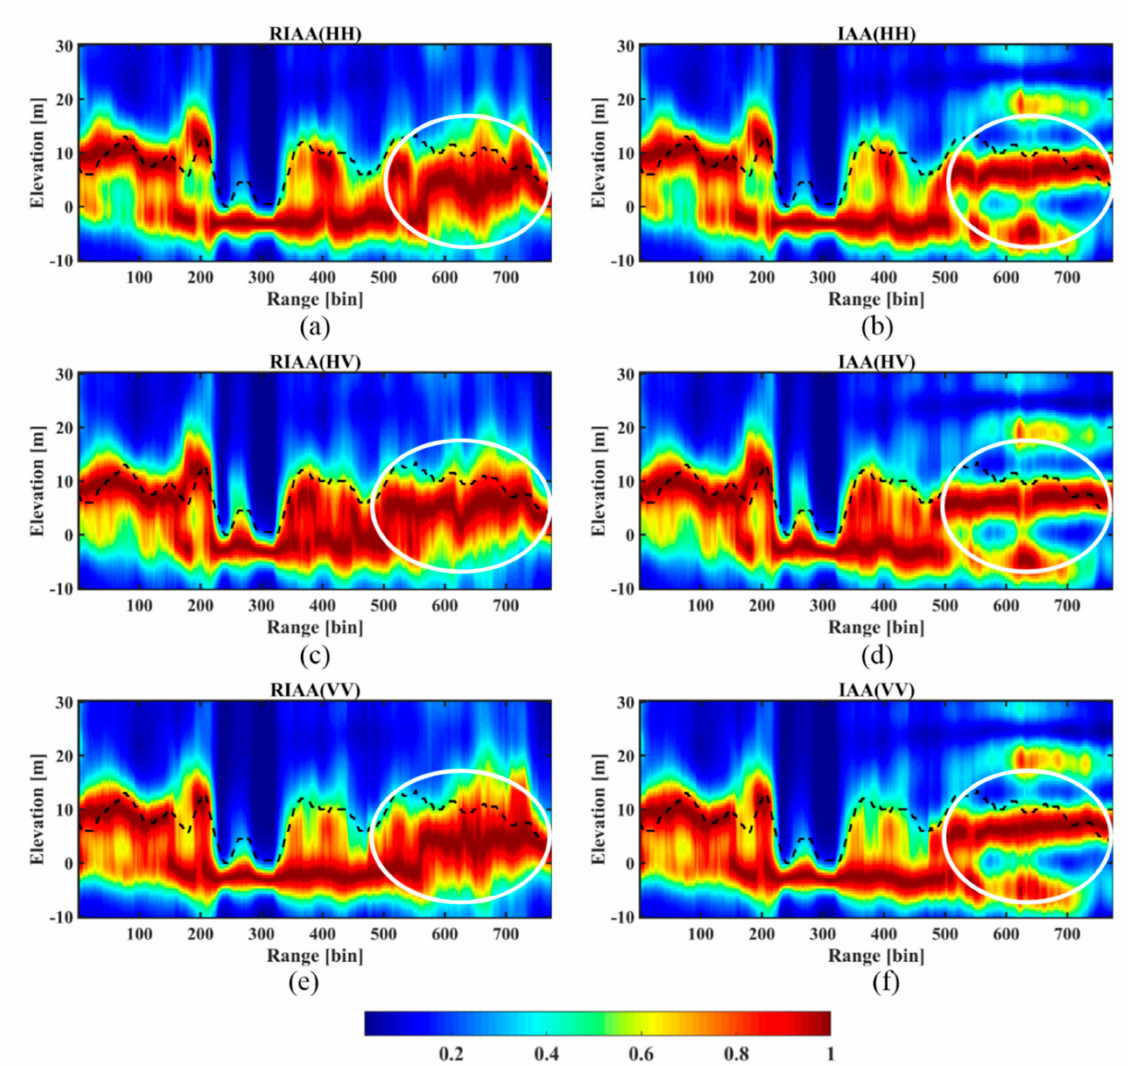
Figure 10. The estimated tomograms of the selected range profile for the two TomoSAR estimators: ( a ) RIAA in HH polarization; ( b ) IAA in HH polarization; ( c ) RIAA in HV polarization; ( d ) IAA in HV polarization; ( e ) RIAA in VV polarization; ( f ) IAA in VV polarization. The black dotted lines represent